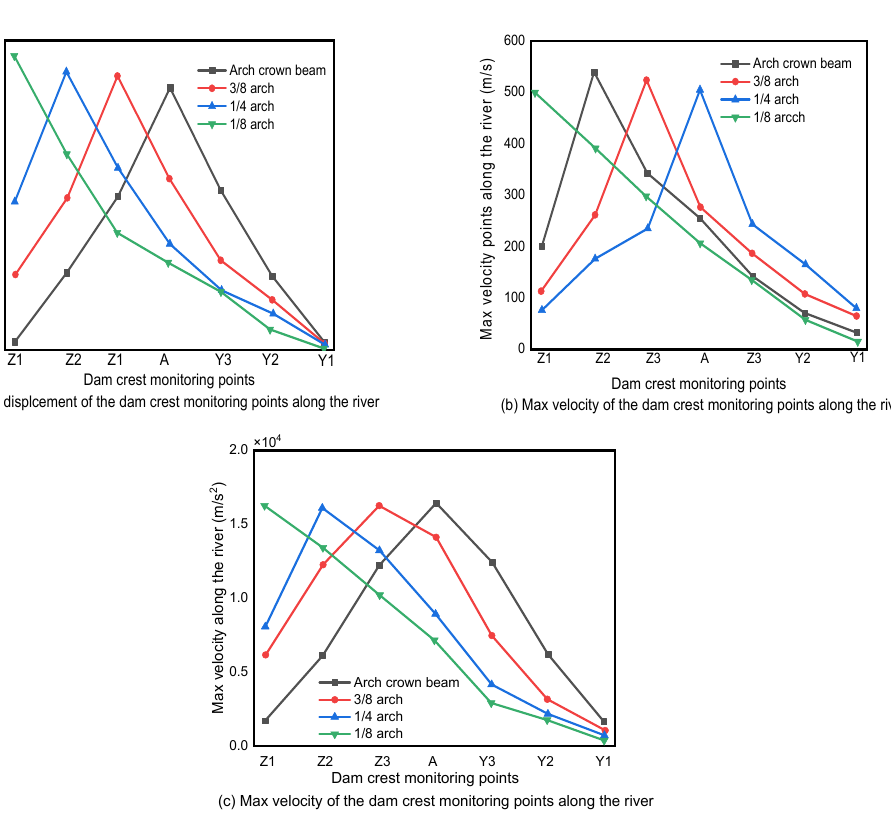
Figure 22. Position of detonation in front of the dam at various water levels.